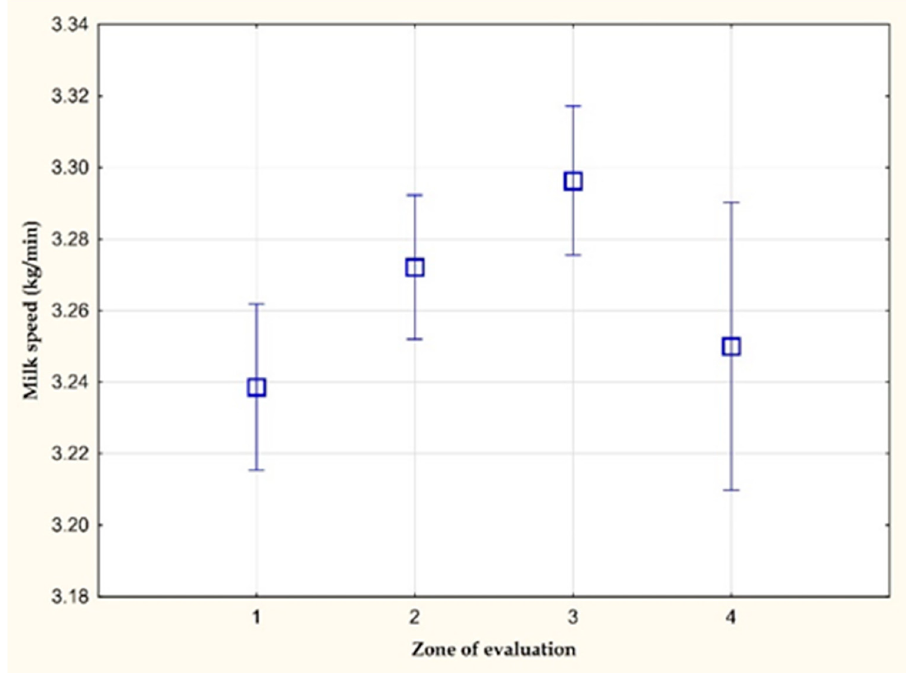
Figure 4. The maximum milk speed (kg/min) on farm C.